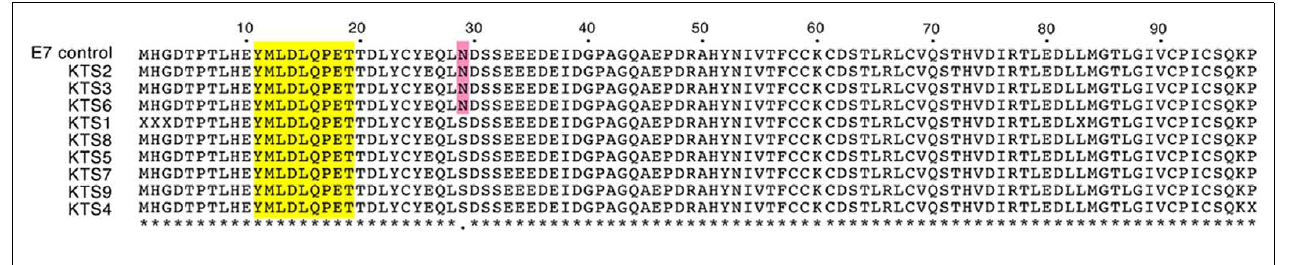
FIGURE 3 | Multiple alignment of HPV-16 E7 protein sequences determined from tumor DNA sequencing. HPV-16 E7 DNA sequences were PCR-amplified from total tumor DNA and sequenced. DNA sequences were translated to and protein sequences aligned for comparison.Two HPV-16 E7 sequence variants are present in the analyzed